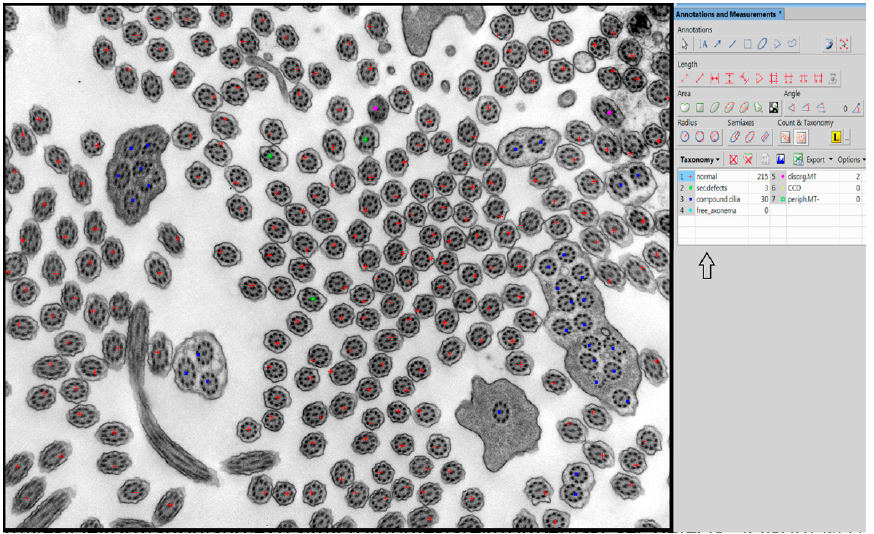
Figure 1. Example of manual evaluation using NIS Elements program with table in the right panel (arrow). Swollen cilia, cilia with vesicle formation and extra microtubules are grouped as “sec.defects”. Disorg.MT = disorganized microtubules, CCD = central pair complex defect, periph.MT- = missing peripheral microtubules. Compound cilia and free axonemes are categorized individually although they belong to secondary